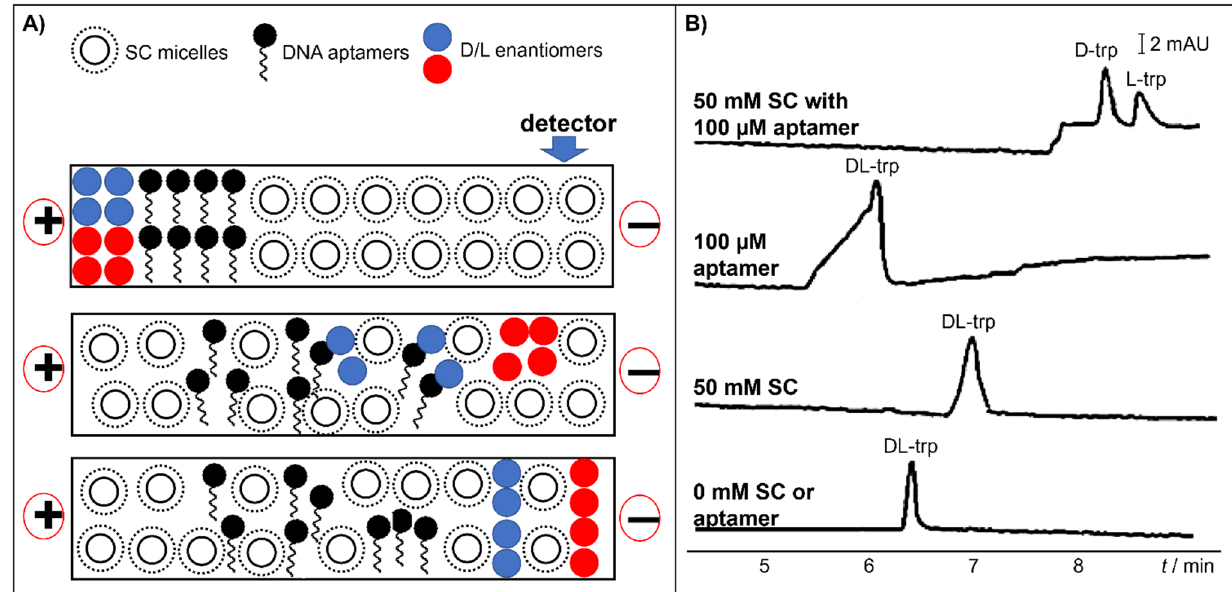
Figure 7. ( A ) Schematic diagram of the procedure of partial filling. ( B ) Electrochromatograms of DL-tryptophan under various CS concentration. BGS contains CS as indicated in each trace. The aptamer is a 34-mer ssDNA specific to DL- tryptophan. Separation conditions: buffer: 2.7 mM KCl, 1 mM MgCl 2 , 10 mM Na 2 HPO 4 , 10 mM NaCl, and 2 mM KH 2 PO 4 (pH 7.4). Sample injection: 0.5 psi for 6 s. Applied voltage: 20 kV. Detection: 280 nm. Capillary dimension: 61 cm (51 cm) × 75 µm. Modified with permission from the authors [57], © 2021 John Wiley and Sons.